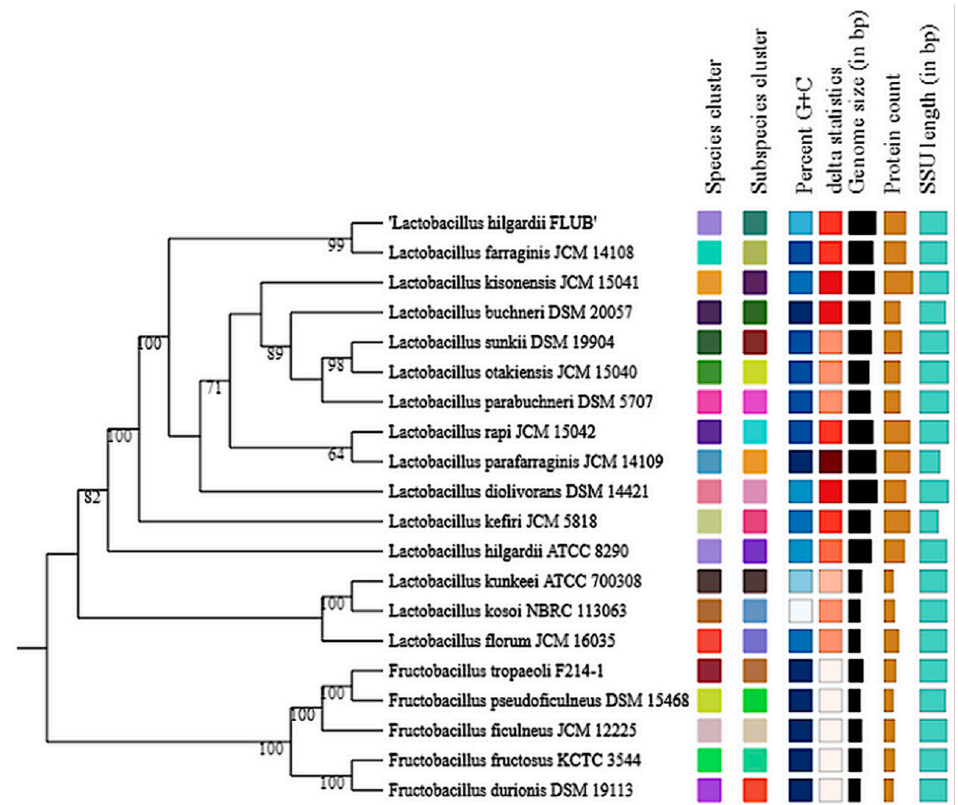
Figure 1. Tree inferred with FastME 2.1.6.1 from GBDP distances calculated from 16S rDNA gene sequences. The branch lengths are scaled in terms of the GBDP distance formula d5. The numbers above the branches are GBDP pseudo-bootstrap support values >60% from 100 replications, with an average branch support of 83.1%. The tree was rooted at the